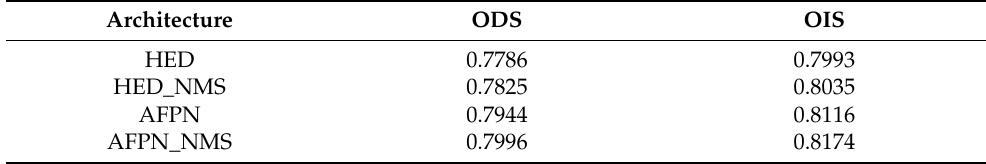
Table 4. Effect of non-maximum suppression layer.